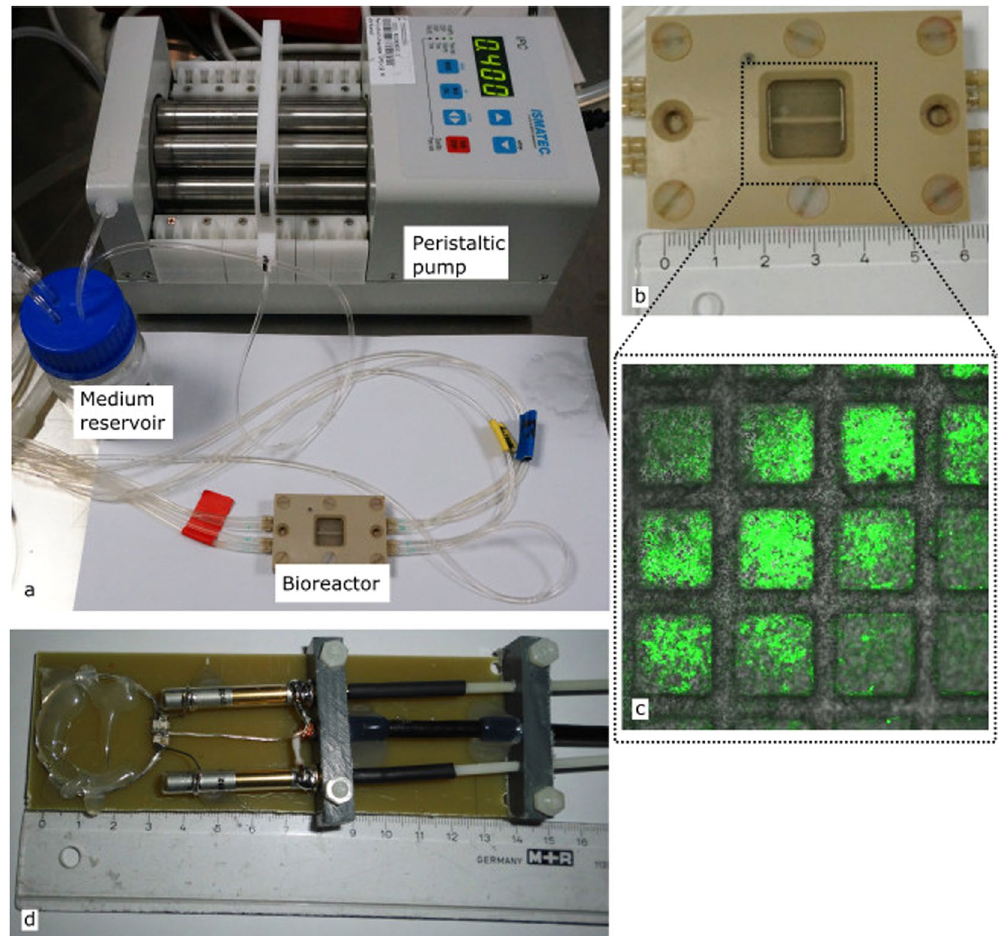
Figure 1. ( a ) Bioreactor connected to the peristaltic pump which produces the pulsatile flow of 400 µ l/min and a reservoir for cell culture medium. ( b ) Zoomed image of the bioreactor. The dotted line shows the area